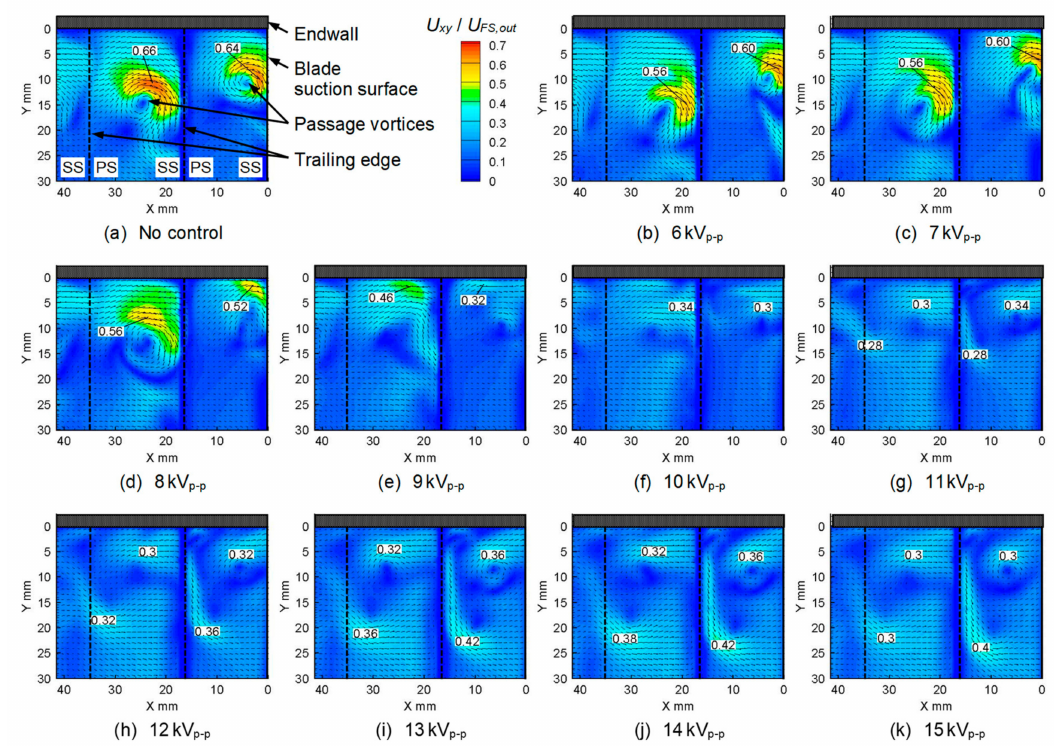
Figure 11. Velocity distributions at the outlet of the linear turbine cascade at various input voltages ( U FS , out = 2.4 m / s).